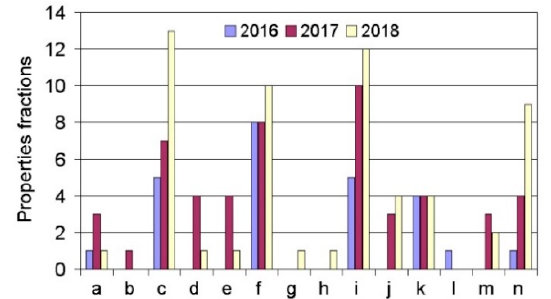
Figure 4. Frequency of the properties tested in research articles containing expert knowledge of new technologies and involving investigations into features of single tracks in laser processing (here, a— mechanical properties, b—structural properties, c—microstructure, d—microhardness, e—hardness,